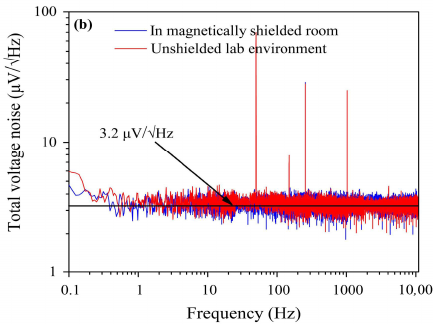
Figure 2. Comparison of the measured voltage noise in unshielded lab environment and in a magnetically shielded room. The blue curve represents the detection in magnetically shielded room and the red curve represents the detection in unshielded lab environment. ( a ) The LC resonance circuit with L ≠ 0; ( b ) The Hall sensor with L ≈ 0. All noise spectra in this paper are recorded by a dynamic signal analyzer (Agilent 35670A produced by Agilent Technologies, Santa Clara, California, USA).